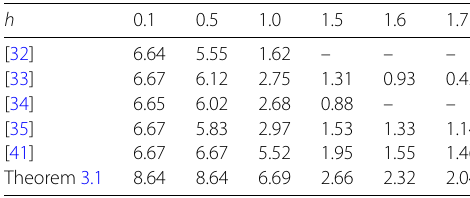
Table 1 The MAUB of r for τ = 0.1 and different values h in Example 4.1